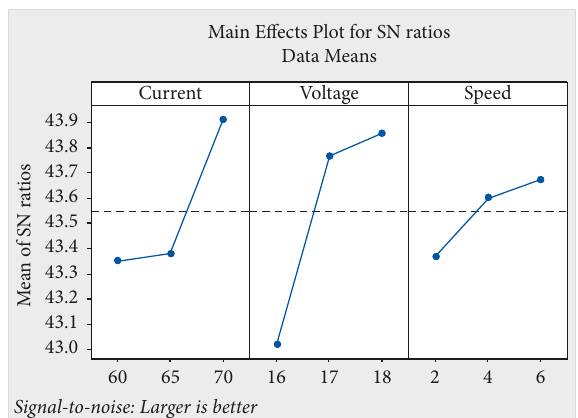
Figure 5: Main effect plot for S/N of hardness of welded